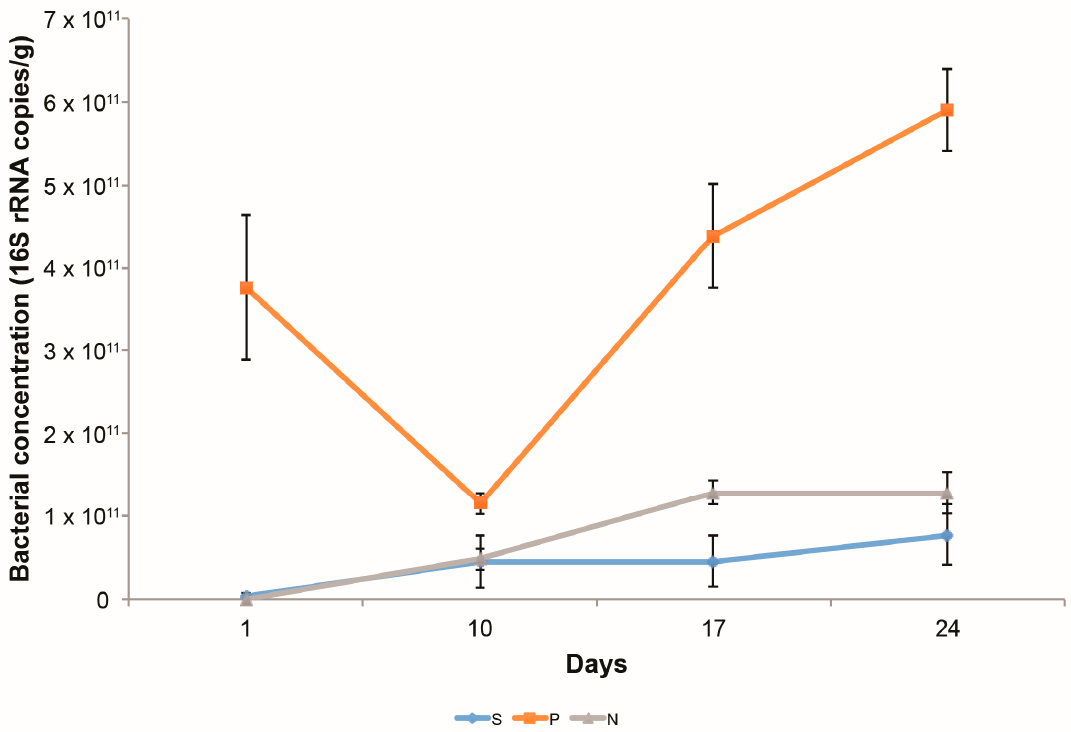
Figure 1. Change in bacterial cell concentration within environmental and control columns over time, as estimated by 16S rRNA gene copy number/ µ L. Abbreviations: S (blue), stormwater-inoculated columns; P (orange), Pseudomonas aeruginosa -inoculated columns; N (gray), non-inoculated columns. Significantly more cells were added in the Pseudomonas columns on Day 1 than in the non-inoculated or stormwater columns. X -axis; Days-days of the experiment from 1 (first day) to 24 (last day). Y -axis; cell concentration as measured by quantitative PCR of 16S rRNA gene copies per gram of sediment in the columns.